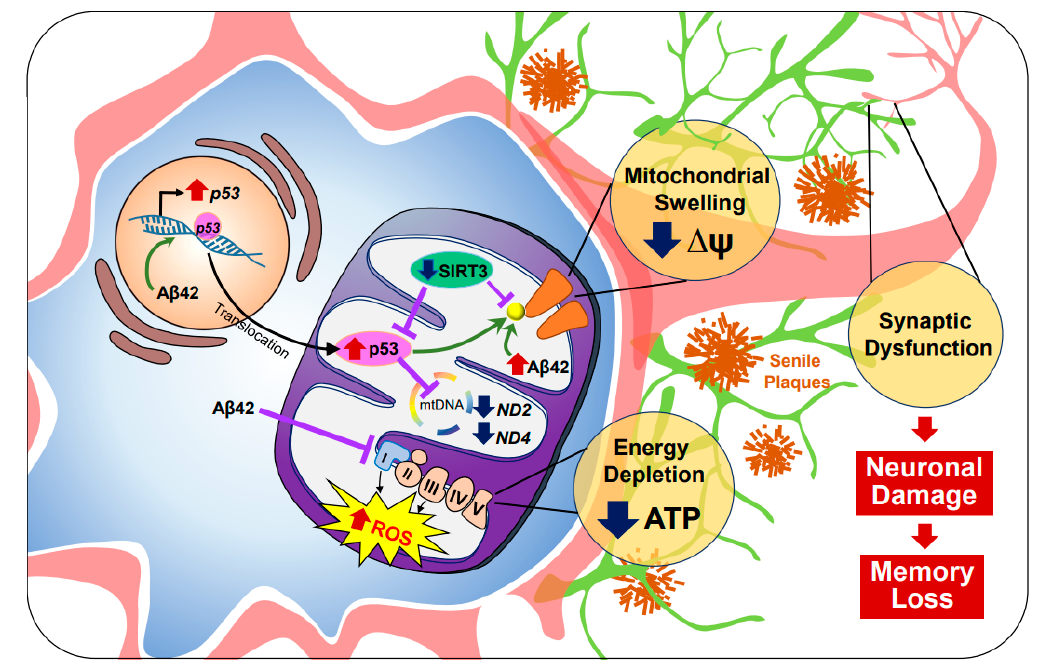
Figure 1. Mitochondrial dysfunction in Alzheimer’s disease. Oligomeric amyloid beta (oA β ) accumulates intracellularly and triggers mitochondrial dysfunction in Alzheimer’s disease (AD). In the nucleus, oA β upregulates the expression of p53. While stress signals are present, p53 is translocated to the mitochondria. Sirtuin-3 (SIRT3), which inhibits p53 as well as cyclophilin D (CypD) activity (yellow) functions as a reactive oxygen species (ROS) modulator, but is downregulated, tipping the balance of respiration in favor of ROS production. While oA β inhibits electron transport chain activity, p53 also represses the production of ND2 and ND4, subunits of complex I, contributing towards overall energy depletion. Subsequently, low ATP levels disturb downstream processes, such as axonal transportation, resulting in synaptic dysfunction. Ultimately, over accumulated p53 and oA β activates CypD, which prolongs mitochondrial permeability transition pore permeability, triggering cell